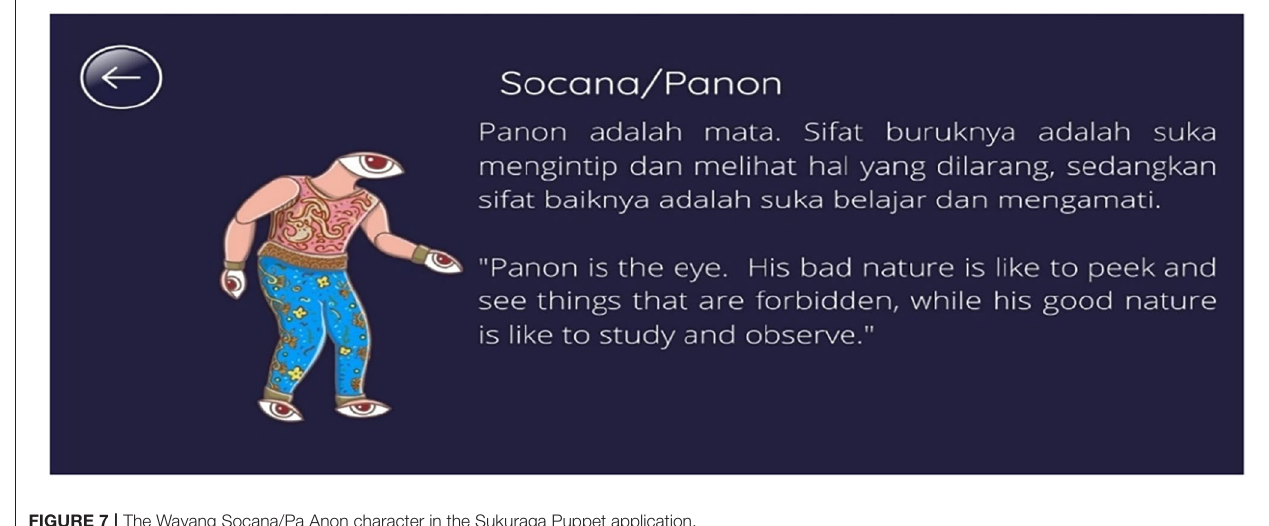
FIGURE 7 | The Wayang Socana/Pa Anon character in the Sukuraga Puppet application.